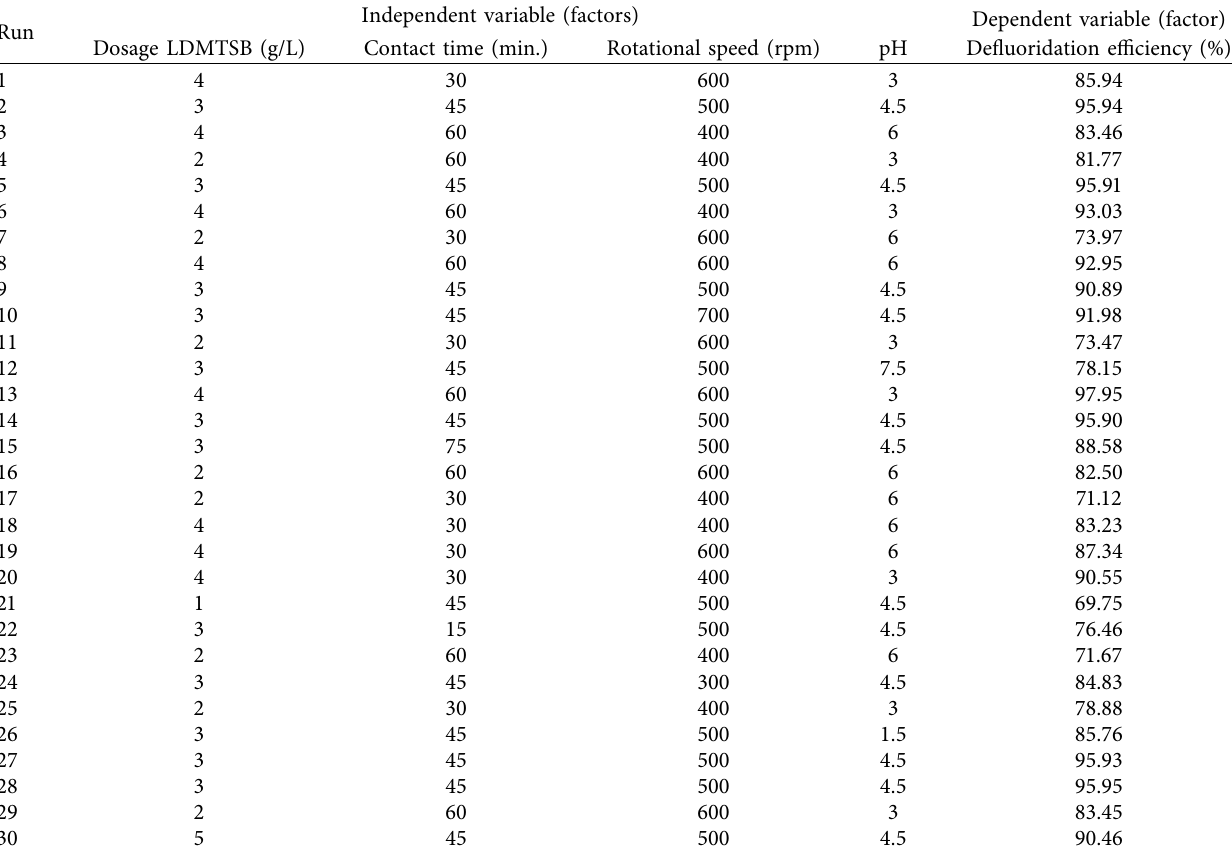
Table 1: Central composite design matrix for defluoridation efficiency.